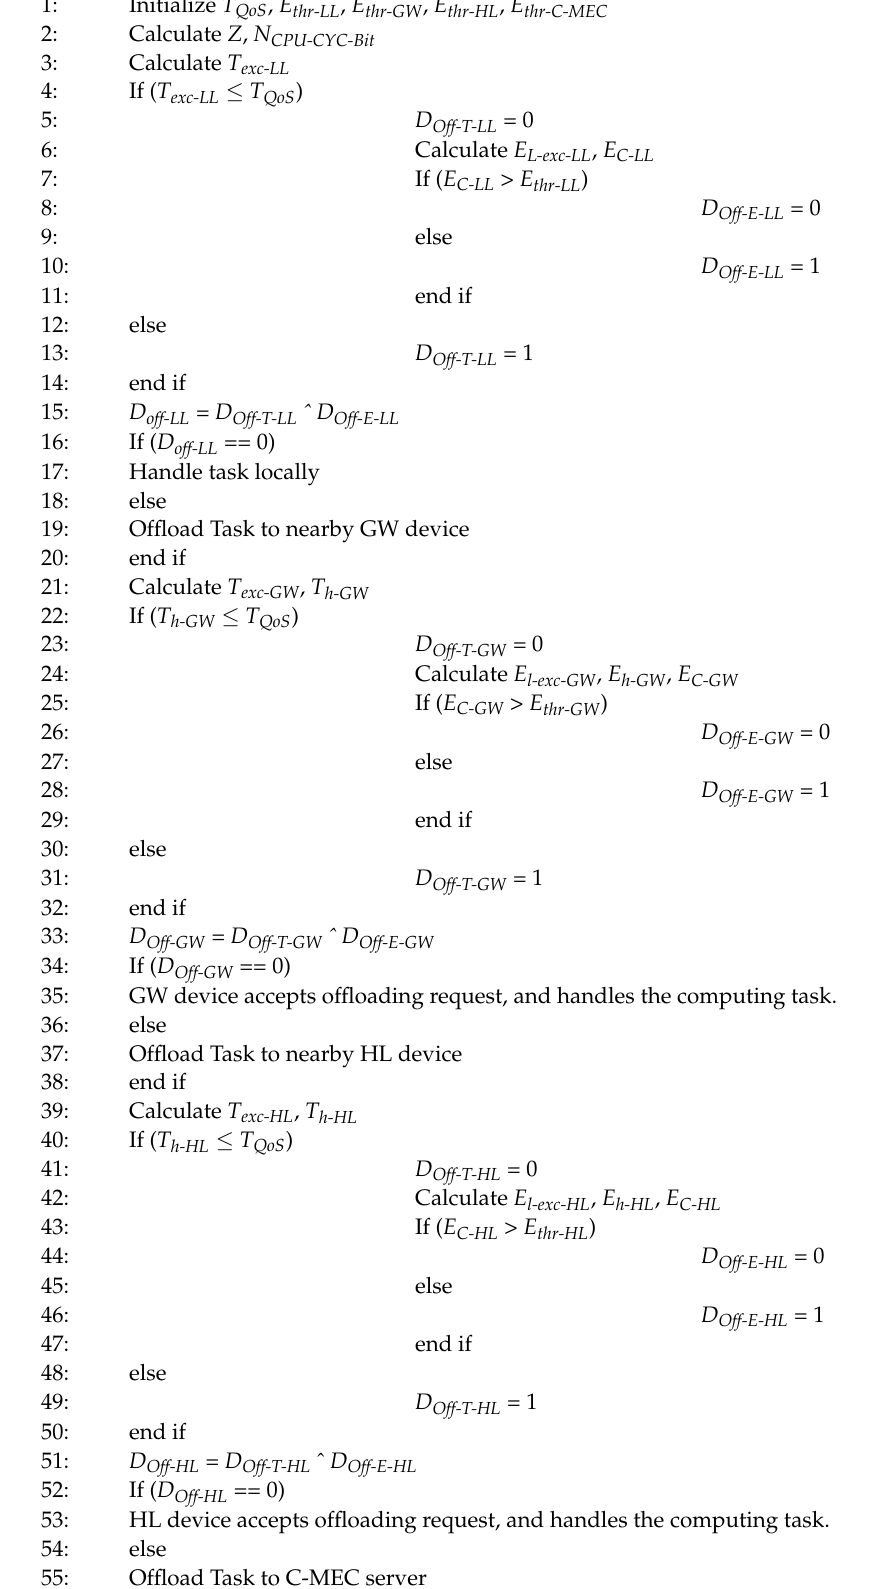
Algorithm 2 Latency-aware and energy-aware offloading algorithm for D2D-based